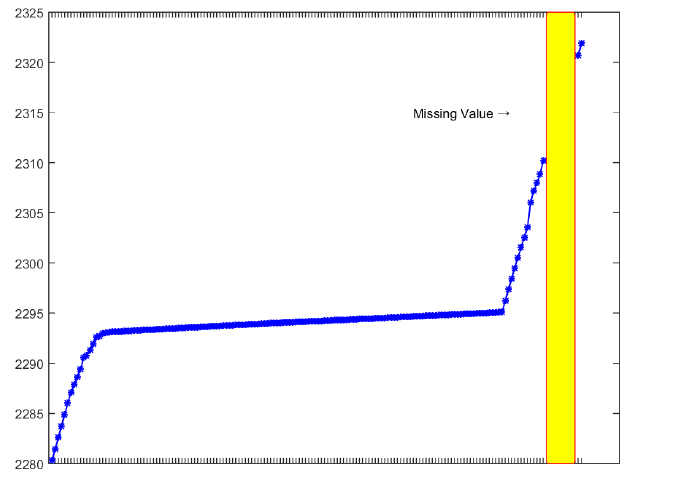
Figure 1. Example of electricity consumption data with missing